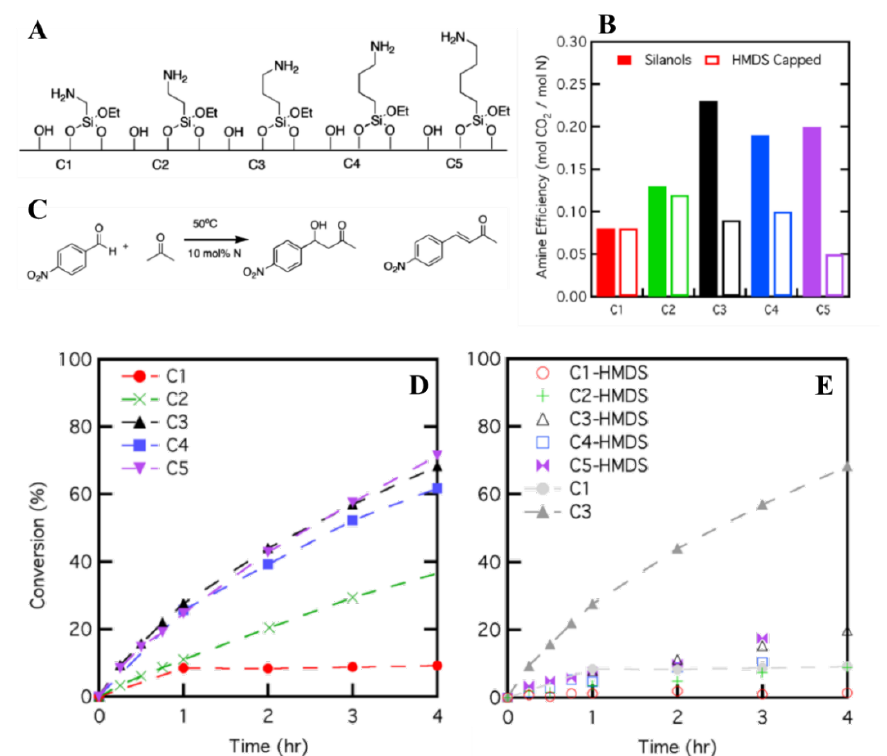
Figure 18. ( A ): Silica-supported alkylamines used as adsorbent and as heterogeneous catalysts. ( B ): Amine efficiencies for CO 2 adsorption (400 ppm in He). ( C ): Schematic representation of the aldol condensation between 4-nitrobenzaldehyde and acetone. Performances of the non-passivated ( D ) and passivated ( E ) hybrids in the reaction between of 4-nitrobenzaldehyde and acetone [99]. Reprinted with permission from [99]. Copyright 2012, American Chemical Society.